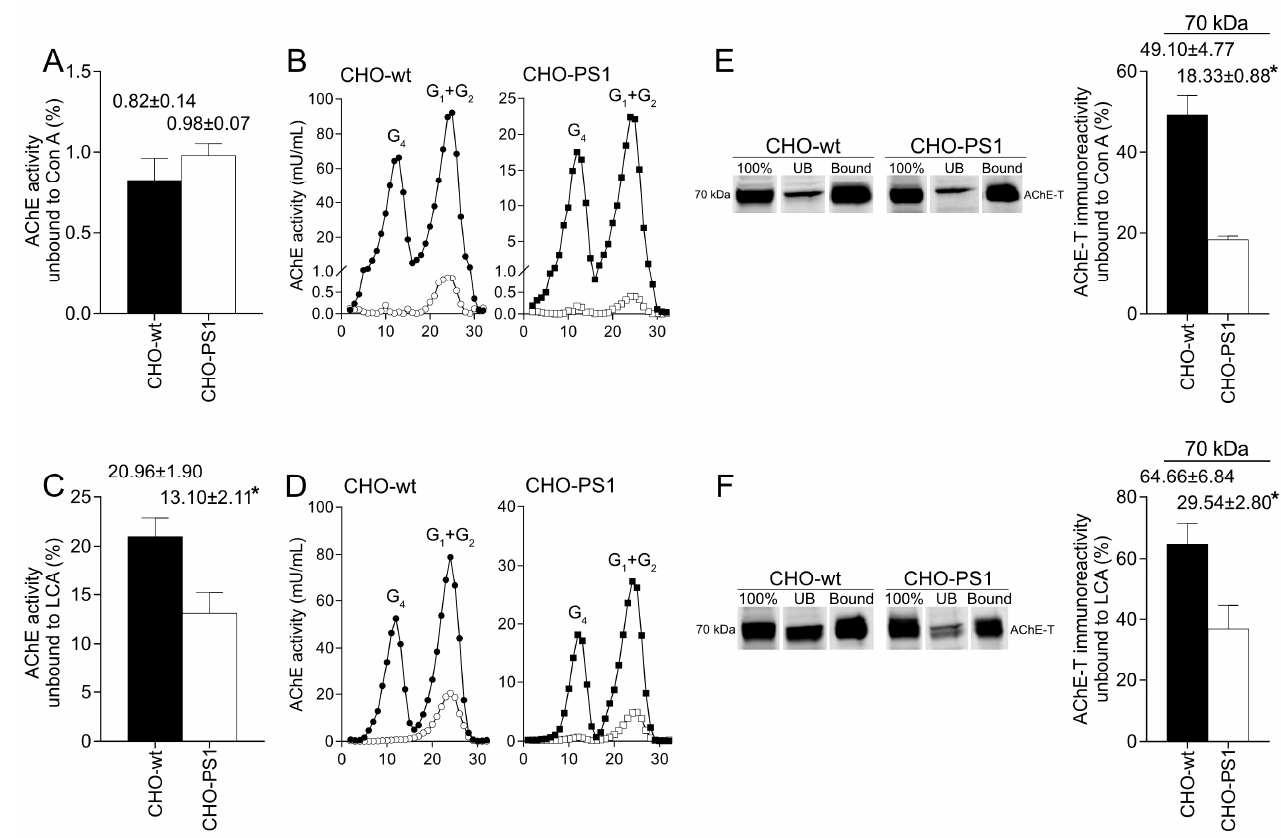
Figure 3. Glycosylation of AChE in CHO cells overexpressing the cholinergic species. Lectin-binding pattern of AChE to Concanavalina ensiformis (Con A) and Lens culinaris (LCA) lectins in CHO-wt and CHO-PS1. Cells were first transfected with AChE-T+PRiMA encoding plasmids that drive the expression of AChE cholinergic tetramers (see Supplemental Figure S2). After interaction with the lectins, the unbound and bound fractions were separated, and AChE interaction was assessed. AChE enzymatic activity was measured in the fractions unbound to the lectins Con A ( A ) and LCA ( C ), and the percentage of activity with respect to AChE activity of the total extract was calculated. The binding of molecular forms of AChE was also analyzed by ultracentrifugation in sucrose gradients. Representative molecular forms patterns of the total extract (closed symbols) and unbound fraction (open symbols) to Con A ( B ) and LCA ( D ) are shown. The glycosylation of AChE protein was analyzed by Western blotting of the samples prior to interaction with lectins (100%), and also the bound and unbound (UB) fractions. The immunoreactivity of the 70-kDa UB AChE was measured and the percentage with respect to 100% was calculated. Representative Western blots of CHO-wt and CHO-PS1 and percentage of the immunoreactivity UB for Con A ( E ) and LCA ( F ) are shown. Results were confirmed in at least 6 independent determinations from three independent experiments. Data represent the mean ± SEM of the percentage of activity or immunoreactivity over the total prior to interaction. * indicates statistically significant ( p value < 0.005) when applying unpaired t -test. On the other hand, LCA interaction was assayed in CHO-PS1, in which PS1 over- expression was knocked down using PS1 siRNA. The PS1 levels were measured and the results demonstrated a steep reduction in PS1 expression 48 h after siRNA transfection (Supplemental Figure S3C). LCA binding assays showed a trend to increase in the amount of AChE enzymatic activity and protein not recognized by the lectin in cells with reduced PS1 levels (Supplemental Figure